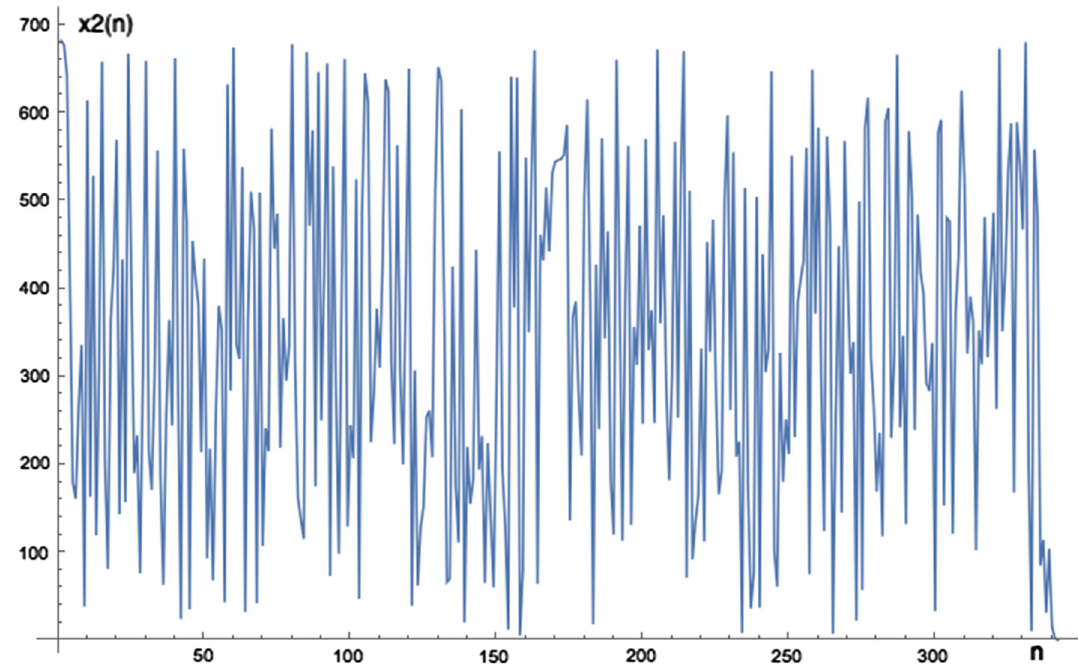
Fig. 3 x ( n ) mod 683 as a function of the time step n . The period is found to be equal to 684 = N + 1 2